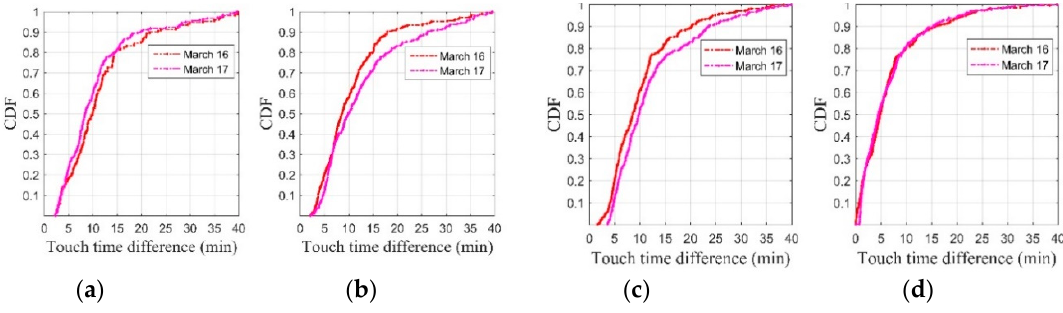
Figure 7. The CDF of metro-to-bus transaction time interval at four stations at 18:00–20:00 on 16–17 March. ( a ) Guomao station. ( b ) Shenzhen University station. ( c ) Daxin station. ( d ) Airport East station. Table 2. The dynamic elapsed time threshold of four survey metro stations estimated in this study. Stations Scenario